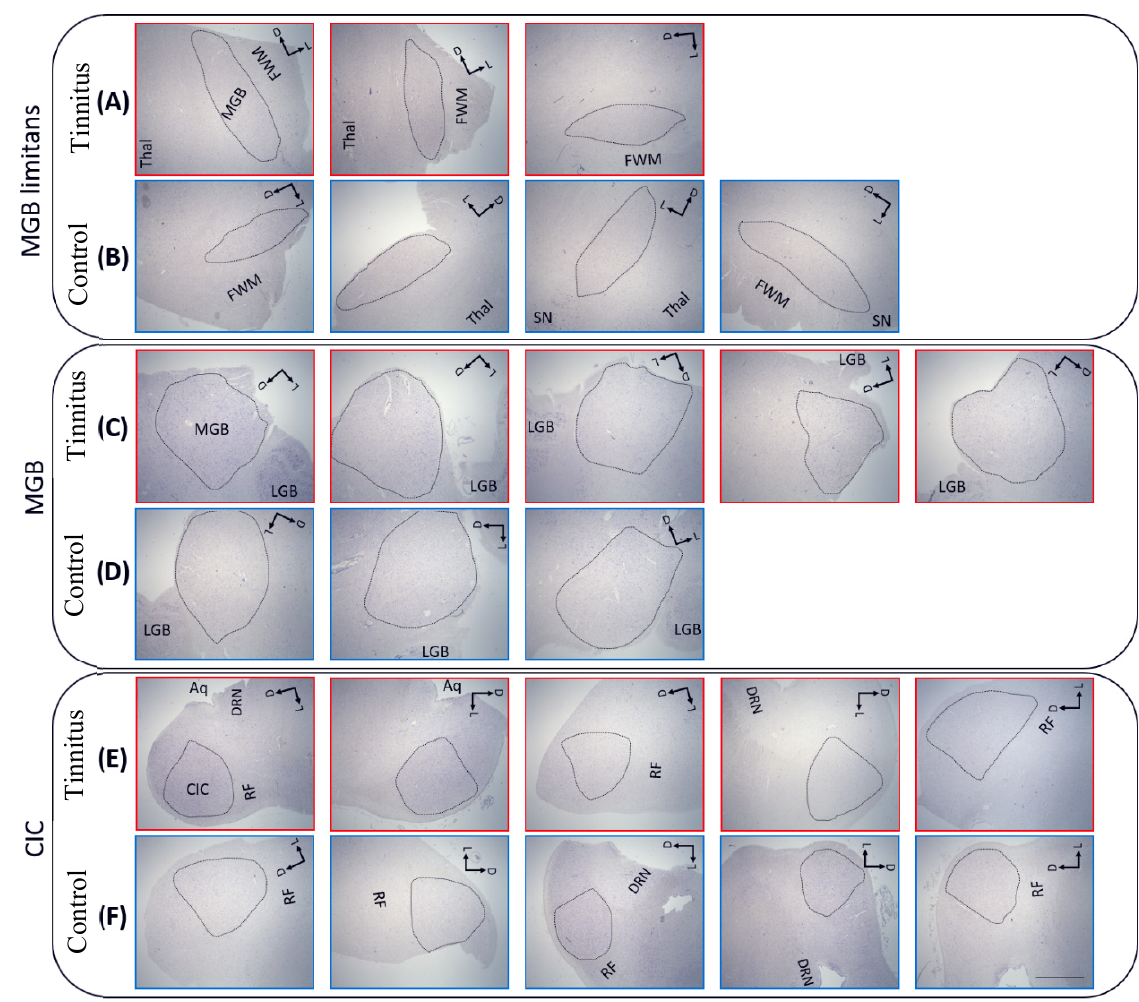
Figure 1. Representative low-power photomicrographs of brain sections per subject stained with Nissl, showing the medial geniculate body (MGB; ( A – D )) and central part of inferior colliculus (CIC; ( E , F )). Two different anatomical levels of the MGB were included: the limitans ( A , B ) and the more caudal round region ( C , D ). Tinnitus subjects are shown in ( A , C , E ) and controls in ( B , D , F ). Scale bar = 2 mm; Aq, cerebral aqueduct; D, dorsal; DRN, dorsal raphe nucleus; FWM, frontal white matter, L, lateral; LGB, latera geniculate body; RF, reticular formation; SN, substantial nigra; and Thal, thalamic nuclei.